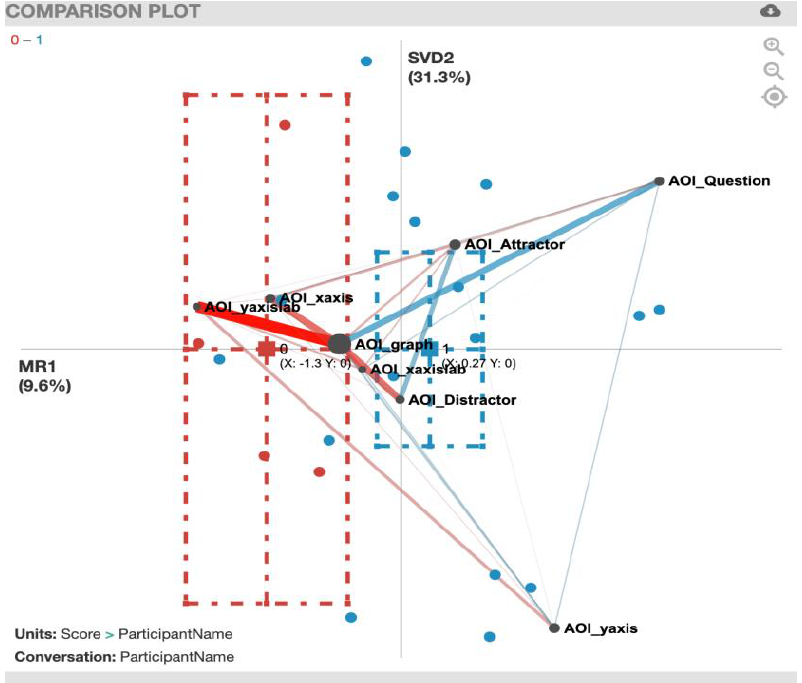
Figure 10. PhySlopeQual transitions with incorrect solvers (red) and correct solvers (blue). For the ENA plot of the EcSlopeQuant task (Figure 11), along the x -axis, a two-sample t -test assuming unequal variance (mean = 0.31, SD = 0.83, N = 18) indicated statistically significant differences at the alpha level = 0.05 (mean = −1.13, SD = 0.41, N = 5; t(14.14) = 5.40, p = 0.00, Cohen’s d = 1.88). Besides a strong gaze transition correlation between the AOI_graph and AOI_Distractor for the incorrect solvers (red), there is a gaze correlation between AOI_Distractor and AOI_Attractor for the correct solvers (blue). For a summary of the strong gaze transition correlations, see Table 6.